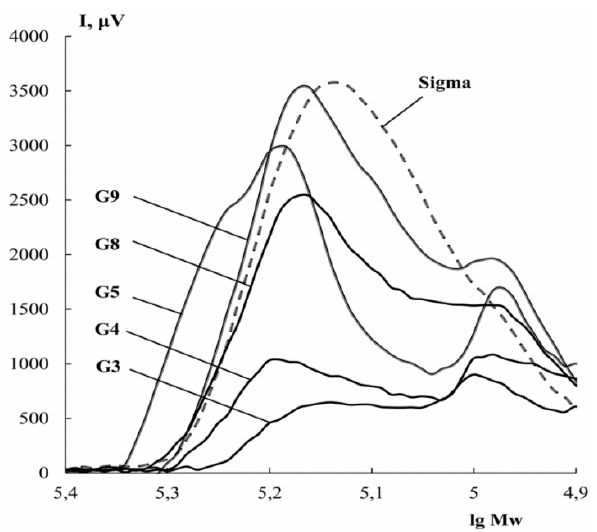
Figure 2. The molecular weight distribution of cod gelatin samples obtained at different pH. Extraction pH is shown as numbers with lines pointing towards curves. Chromatograms were obtained by an high-performance liquid chromatography (HPLC) method.